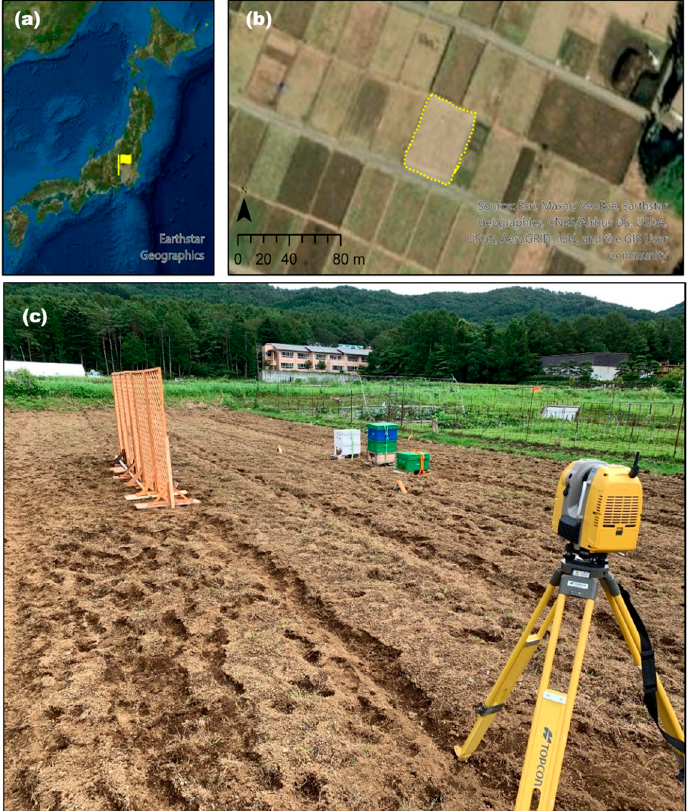
Figure 1. ( a ) Site of the experimental apiary in Japan; ( b ) Aerial image of the experimental apiary; ( c ) Hives and lattice fences installed in the experimental apiary, with a 3D laser scanner set next to the lattice fence (Photographed in the Yamanashi Prefecture, August 2021 by the first